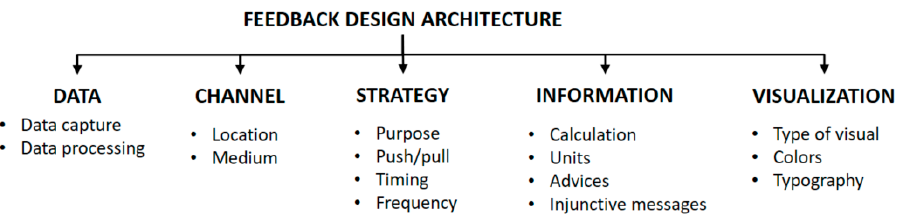
Figure 5. Feedback design architecture.